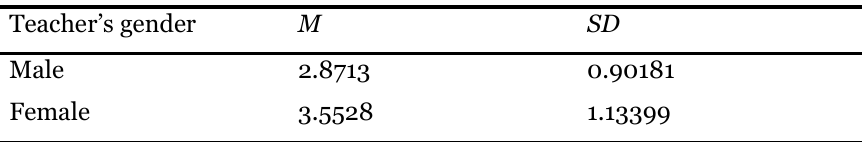
Means and Standard Deviations of Parents’ Perceptions Toward the Distance Learning Process According to Teacher’s Gender